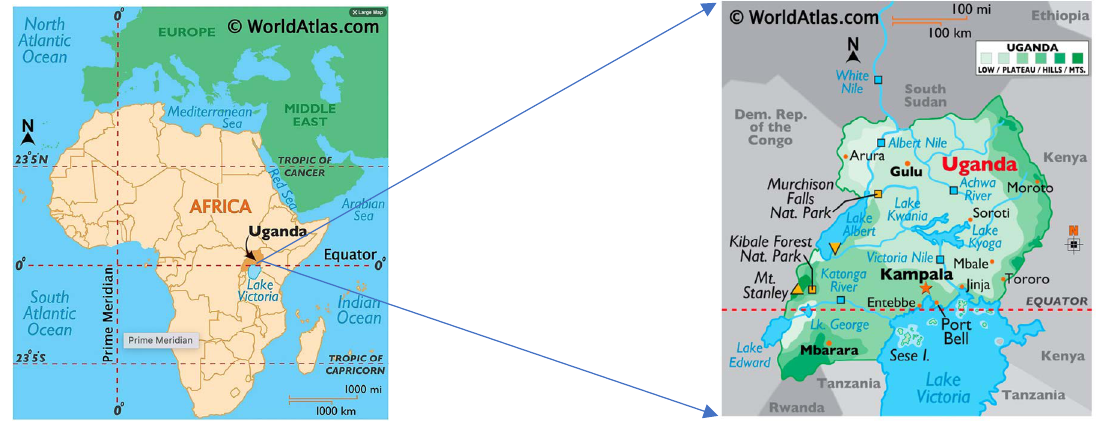
Fig. 1: Geographical location of study area (a) Uganda (b) Kampala City